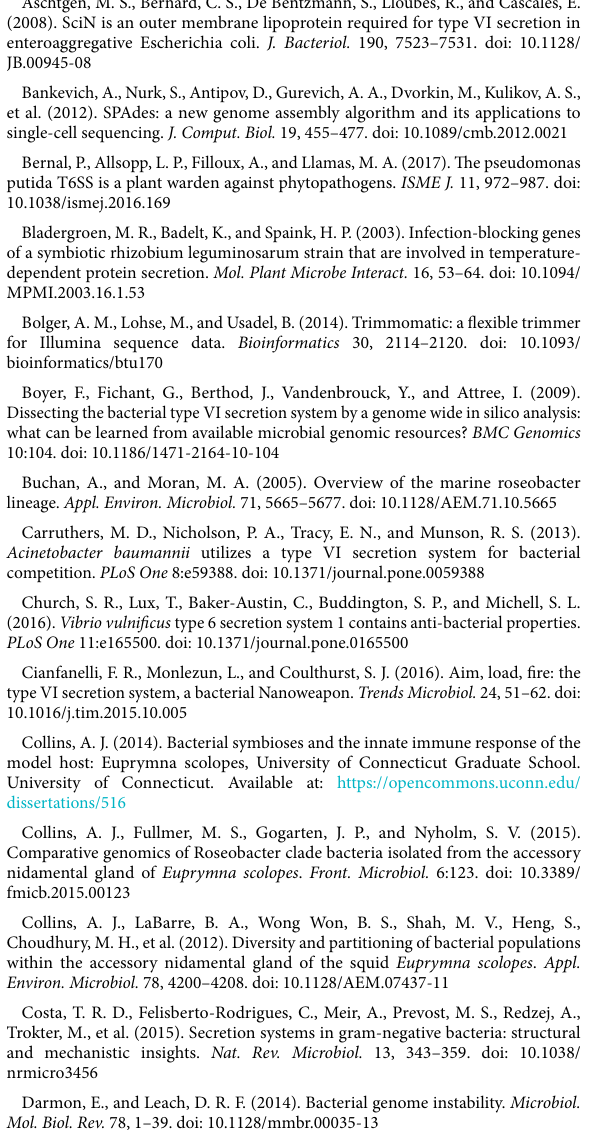
SUPPLEMENTARY FIGURE S2 Coincubation assay confirms that V. fischeri strains with a predicted T6SS2 gene cluster are also lethal against V. fischeri ES114. V. fischeri light organ symbionts isolated in this study were coincubated in mixed spots with the GFP tagged V. fischeri ES114 pVSV102. Strains that inhibit growth